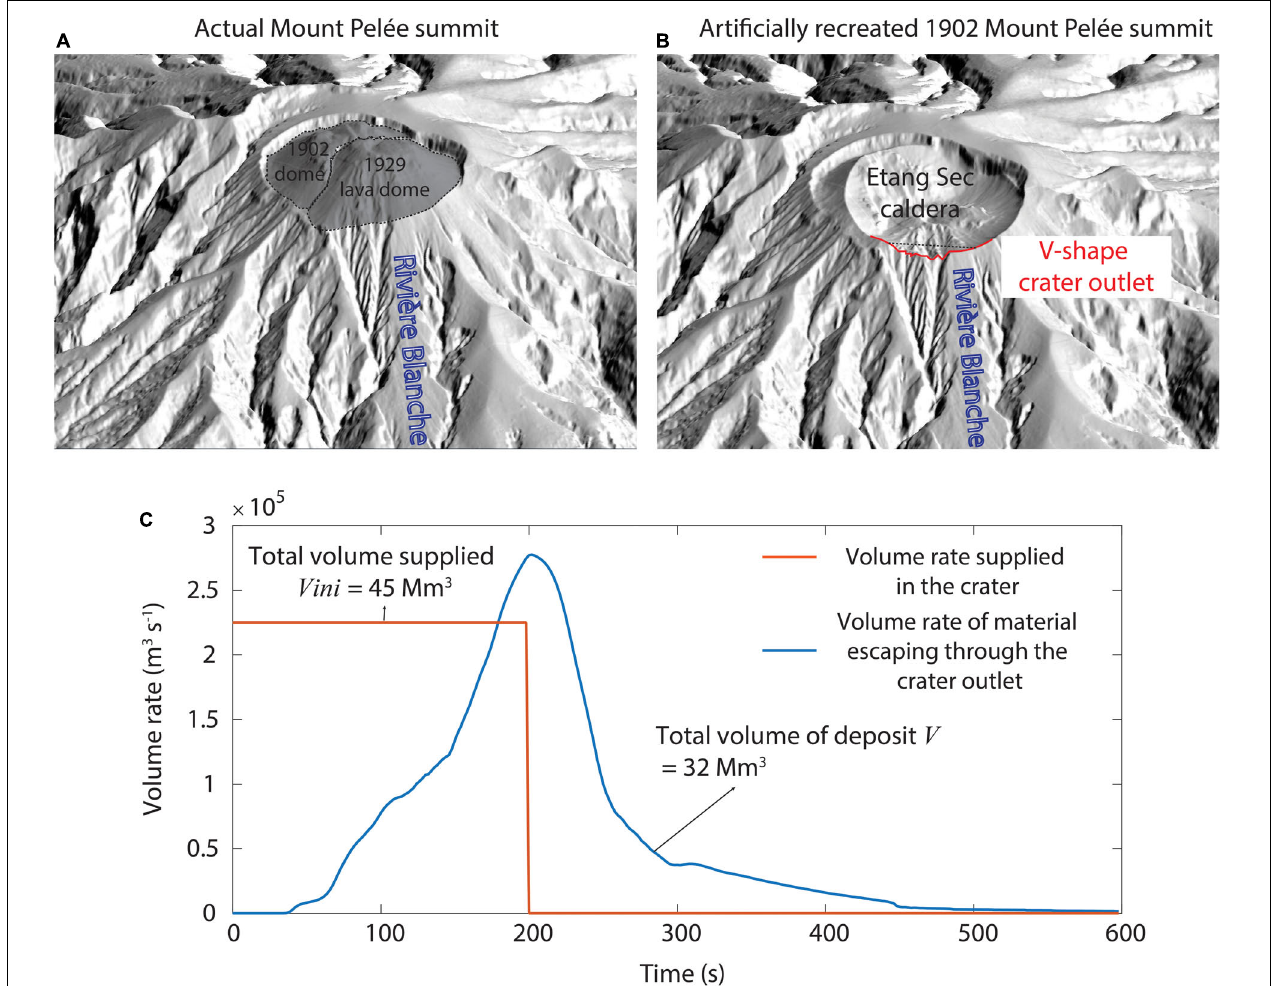
FIGURE 6 | Illustration of the digital topographic modifications performed for this study between the actual Mount Pelée summit (A) and the DEM used in the simulations with the new synthetic 1902 Etang Sec caldera topography (B) . The red line in B highlights the position of the newly formed V-shape crater outlet. (C) Illustrates the variation of the volume rate supplied in the crater (red line) and the resulting volume rate of block-and-ash flow that overflows to the Rivière Blanche through the crater outlet (blue line) during the VolcFlow